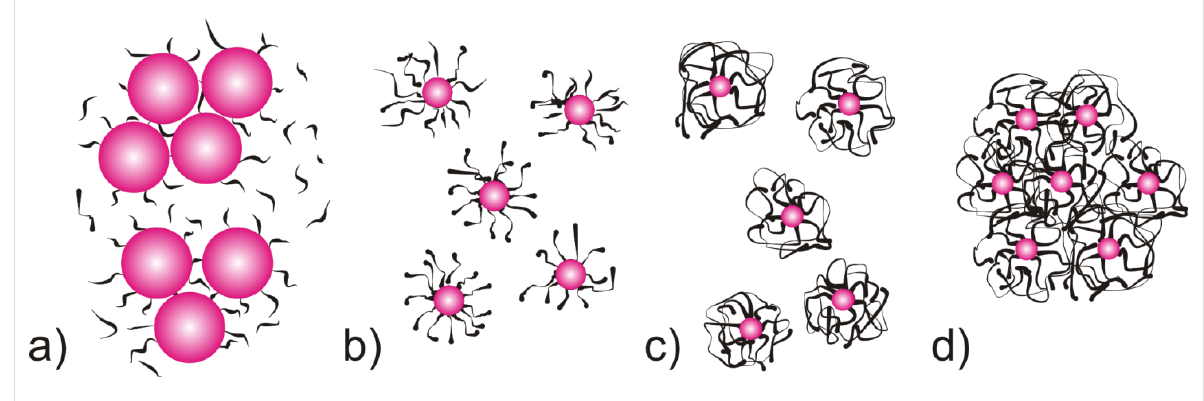
Figure 7: SnO 2 nanoparticle stabilisation scheme depending on the chain length of PEI: a) low molecular weight, b) average molecular weight, c) high molecular weight and d) high molecular weight with too high concentration.